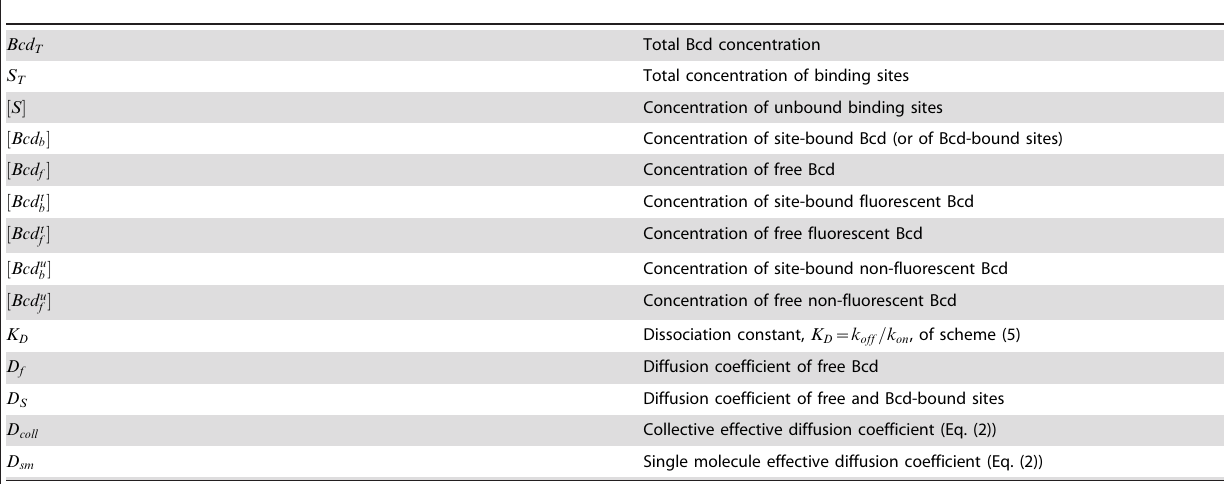
Table 1. List of main symbols used in this